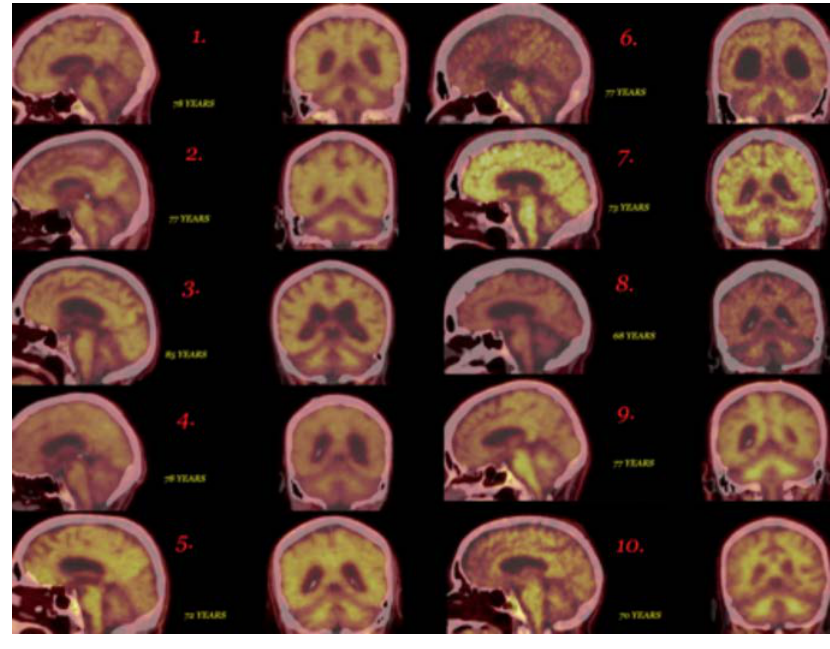
Figure 1. Composite analysis of all ten patients displaying 18F-flubetapir in the sagittal and coronal planes.